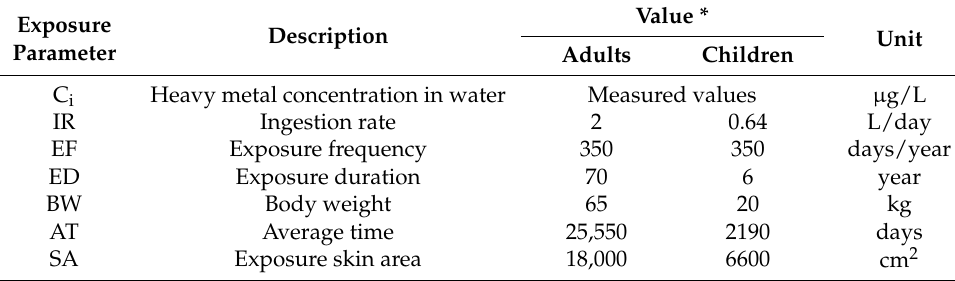
Table 1. Exposure parameters for health risk assessment.